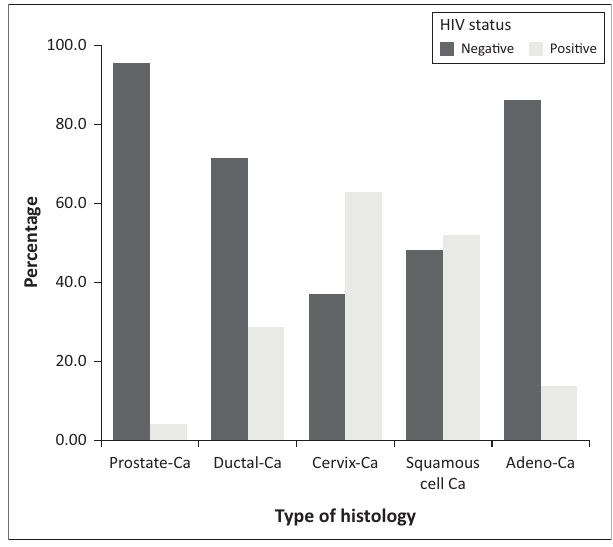
FIGURE 4: HIV status by